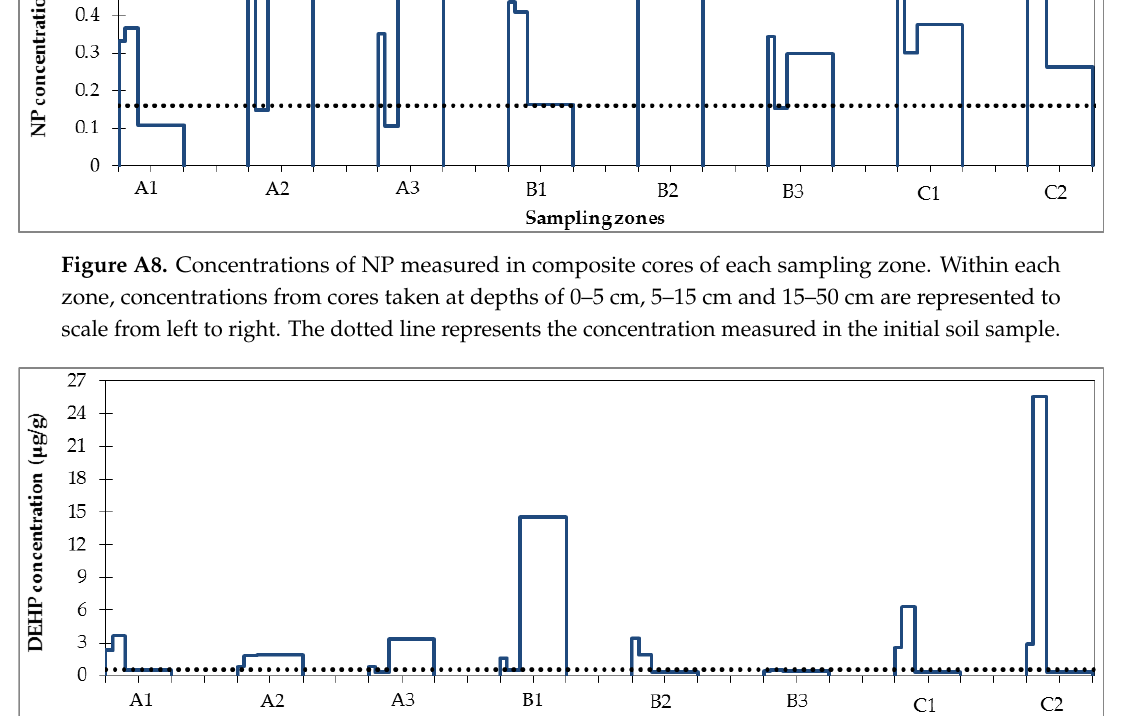
Figure A9. Concentrations of DEHP measured in composite cores of each sampling zone. Within each zone, concentrations from cores taken at depths of 0–5 cm, 5–15 cm and 15–50 cm are represented to scale from left to right. The dotted line represents the concentration measured in the initial soil